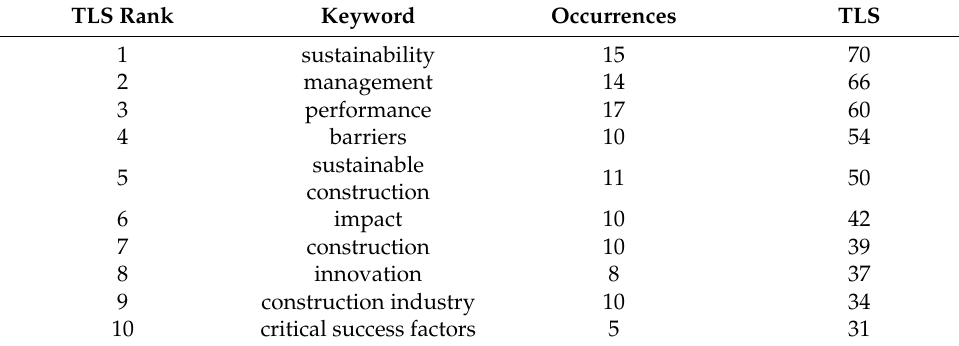
Table 4. Main topics of research